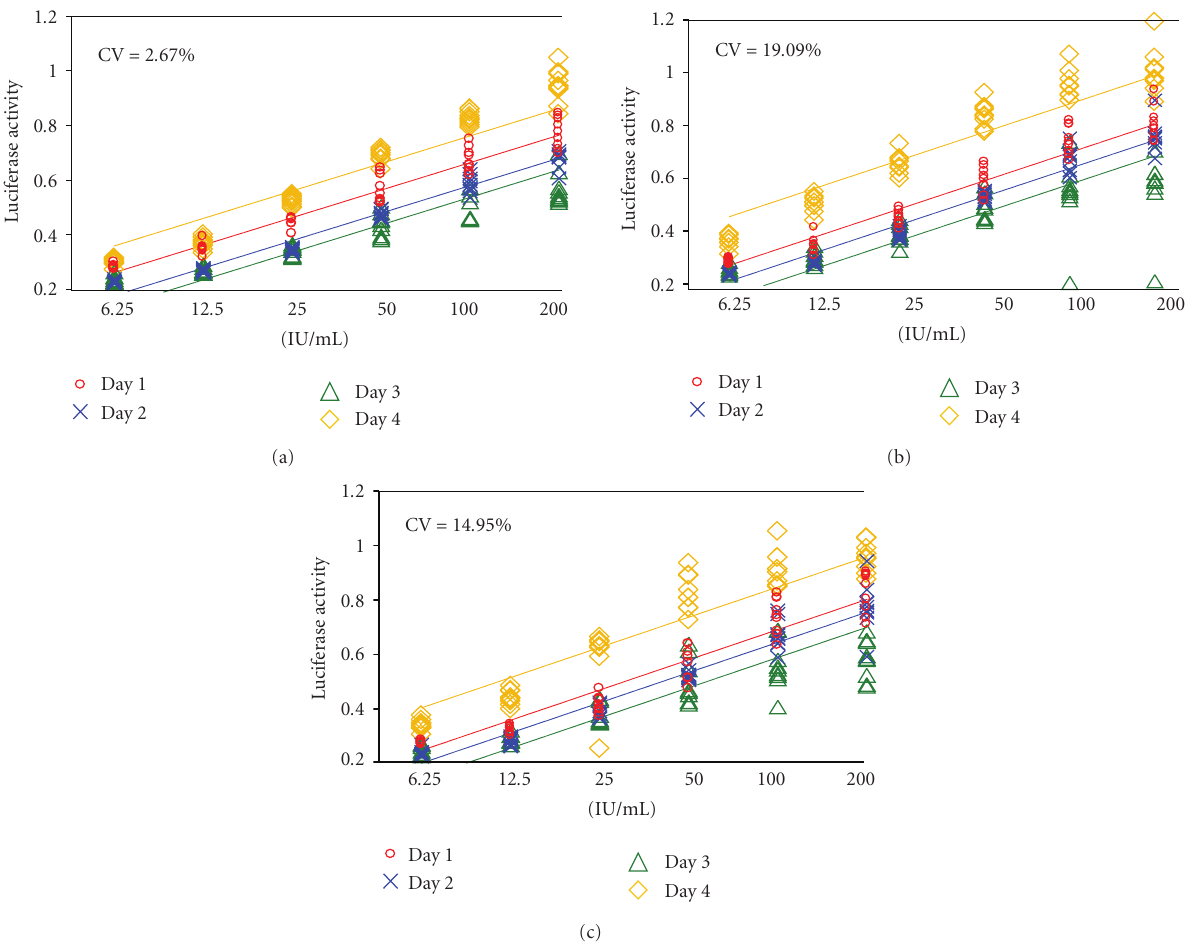
Figure 3: Inter-assay variations (di ff erent runs). Three samples were used. Sample 1 was the in-house reference standard (a), with sample #2 and #3 being final products (b,c). Each dose was run in triplicate and tested on 3 separate plates. The graphs represent the linear range of the tested doses as determined by comparison to the international reference standard. The experiments were conducted on 4 di ff erent